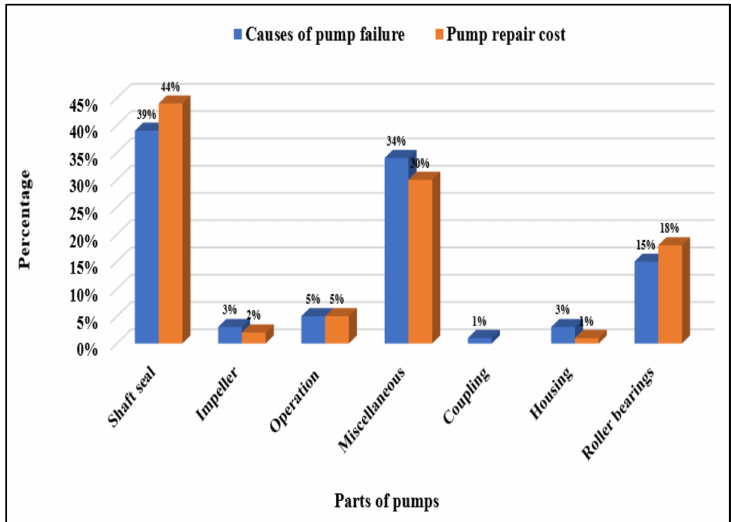
Figure 4. Failure causes and repair cost-distribution